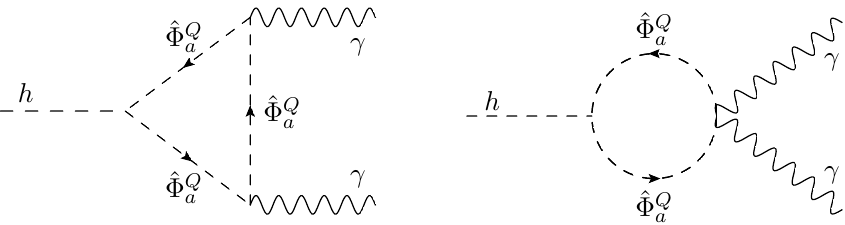
Figure 3. The two types of diagrams that induce NP effects in h → γγ . For h → gg the photons can simply be replaced by gluons, for h → Zγ one photon can be replaced by a Z boson. The additional diagrams with reversed charge flow are not